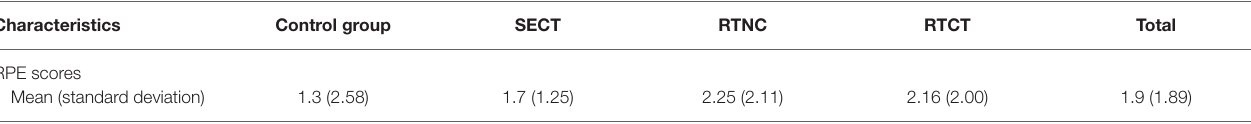
TABLE 4 | Rate of perceived exertion scores measured using Borg’s modified CR10 RPE scale.